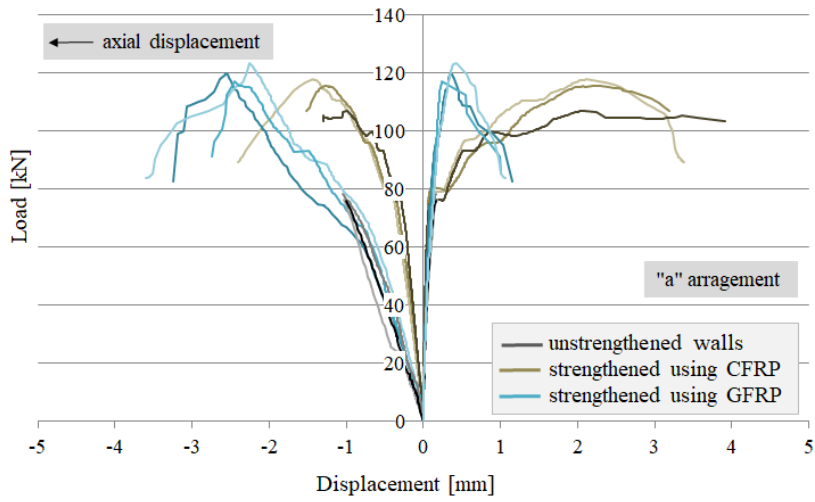
Figure 6. Horizontal and vertical displacement of the tested walls—configuration ‘a’. Table 5. Specific forces and stresses characterizing the walls strengthened in configuration ‘a’.